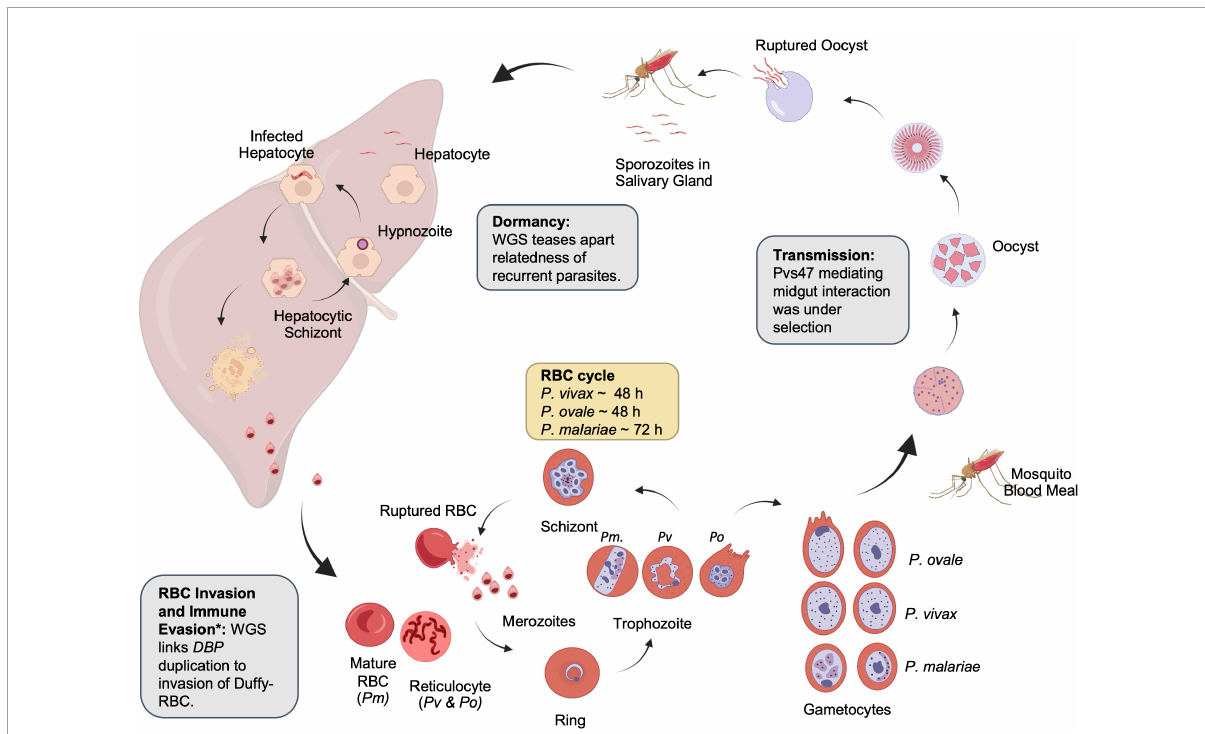
FIGURE2 Lifecycle of non-falciparum malaria parasites. Examples of the contribution of whole-genome sequencing to parasite biology are shown in boxes. Created with BioRender.com. *The identification of the relationship between duffy-binding protein duplication and immune evasion was identified with